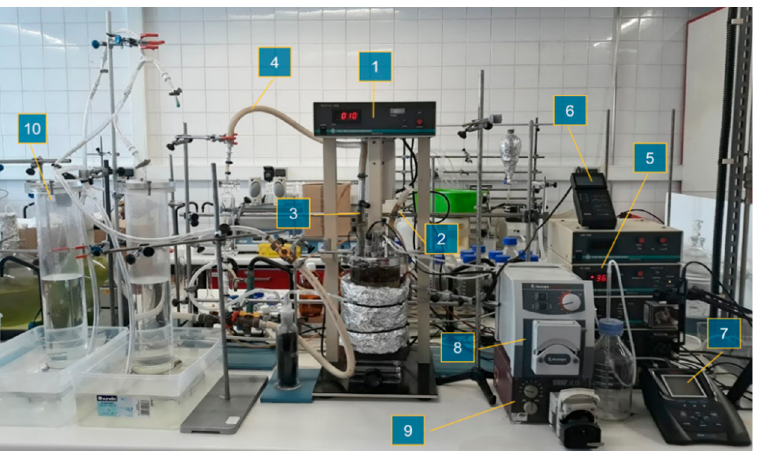
Figure 1. Experimental setup: ( 1 ) stirring system with an external engine and shaft; ( 2 ) feeding tube (influent); ( 3 ) outflow tube (effluent); ( 4 ) biogas outflow line; ( 5 ) temperature controlling system; ( 6 ) redox potential module; ( 7 ) pH and conductivity meter; ( 8 ) HCl pumping system; ( 9 ) influent pump; and ( 10 ) water columns for biogas storage.